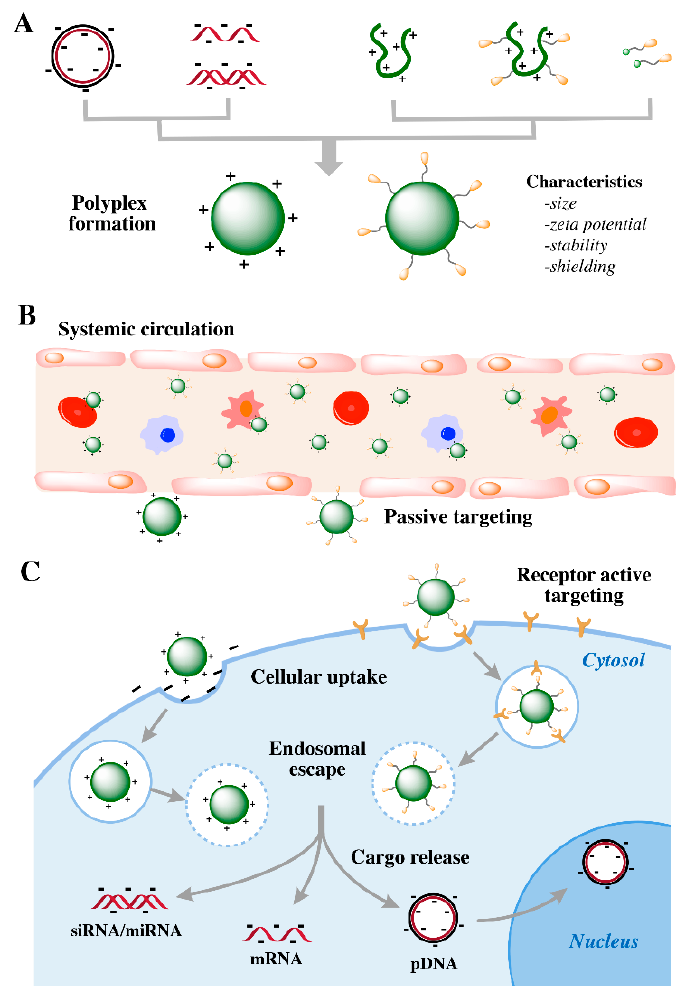
Figure 4 . Pharmacological barriers for systemically administered non-viral targeted nucleic acid delivery. ( A ) Production of stable nucleic acids-loaded polyplexes. ( B ) After intravenous injection, nanocarriers shall avoid unspecific interactions with blood components and rapid clearance, accumulating in targeting areas during circulation. ( C ) After the passage of fenestrated blood vessels, nanocarriers shall be internalized by target cells via an active transport process, and realize efficient endosomal escape and release the cargos in an active form for gene expression or regulation.